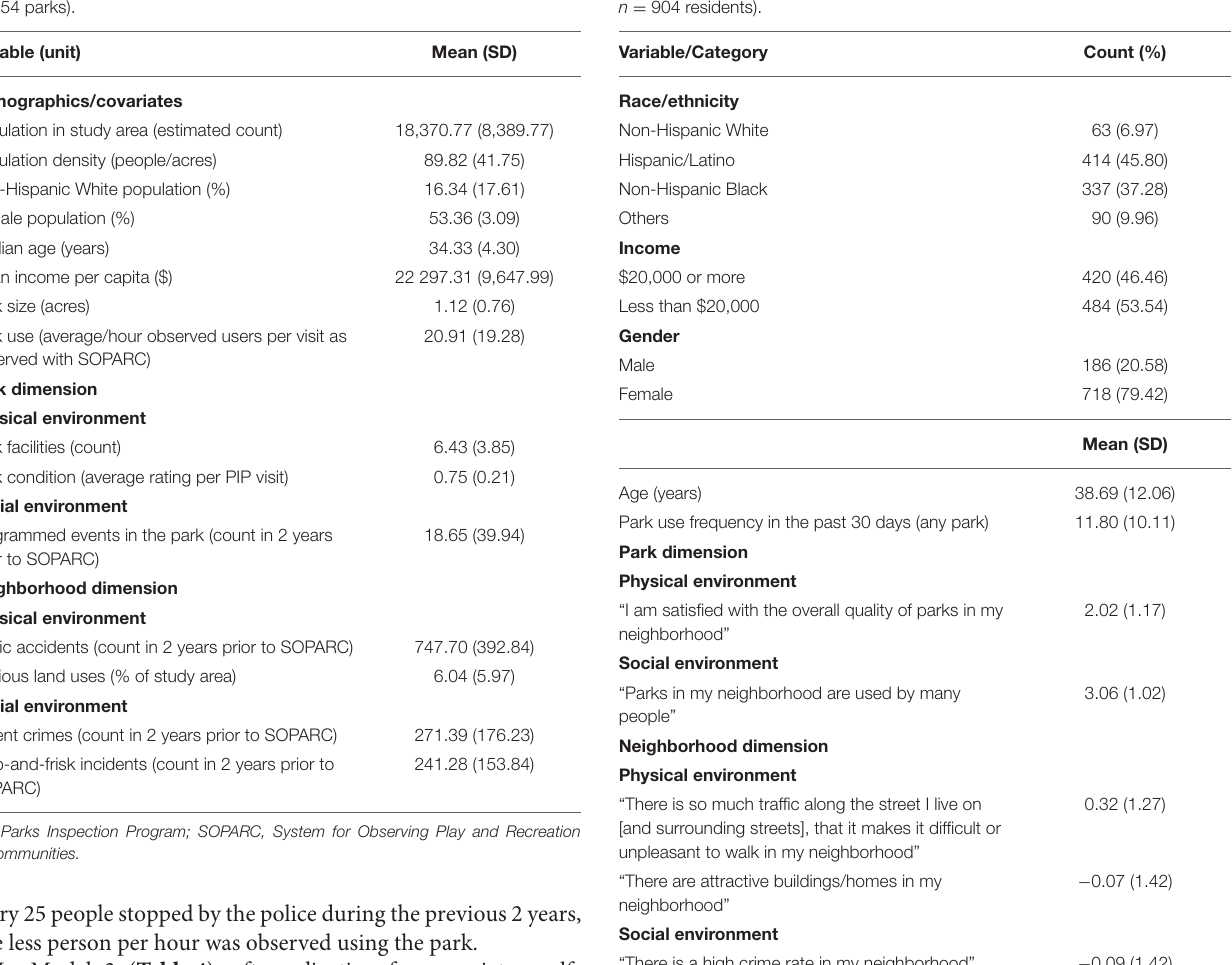
TABLE 3 | Descriptive statistics for Model 2 (individual-level analysis, n = 904